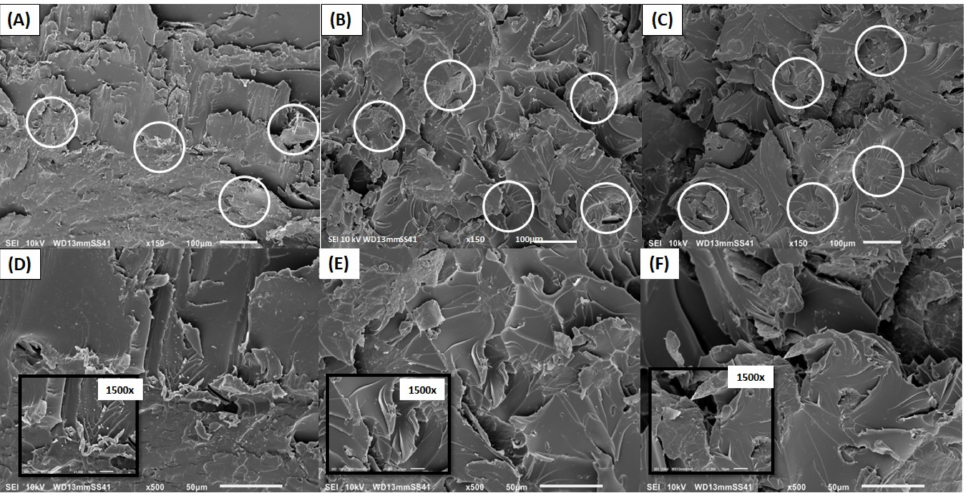
Figure 9. SEM micrographs (150 × ), (500 × ), and (1500 × ); ( A , D ) GO2/epoxy-1, ( B , E ) GO2/epoxy-2, and ( C , F )